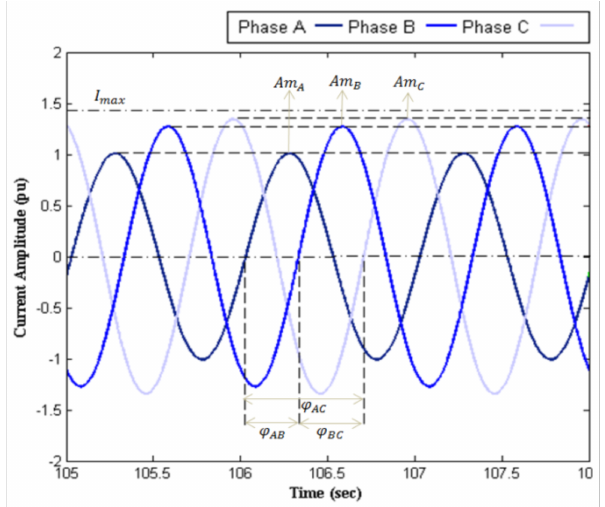
Figure 10. Network currents without